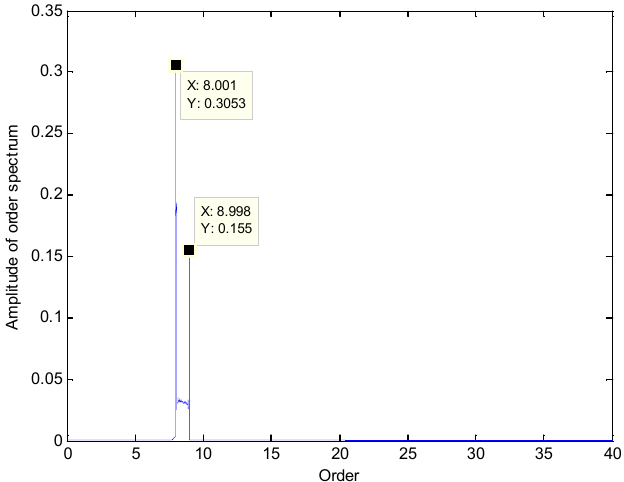
Figure 8. Order spectrum of the angular-domain reconstruction signal.